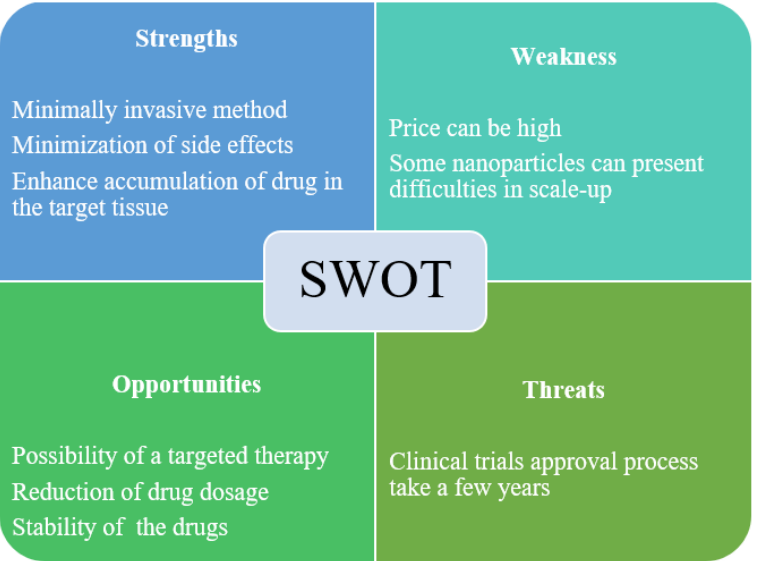
Figure 10. Strengths, weaknesses, opportunities and threats (SWOT) analysis of nanoparticles for Phototherapy.